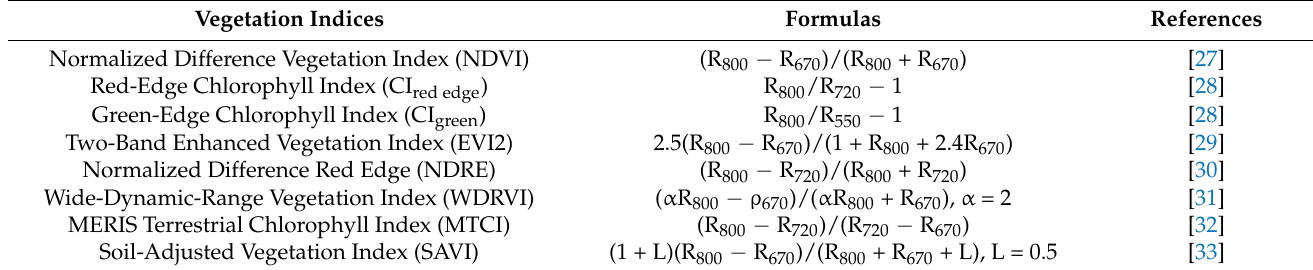
Table 1. The common spectral indices selected in this